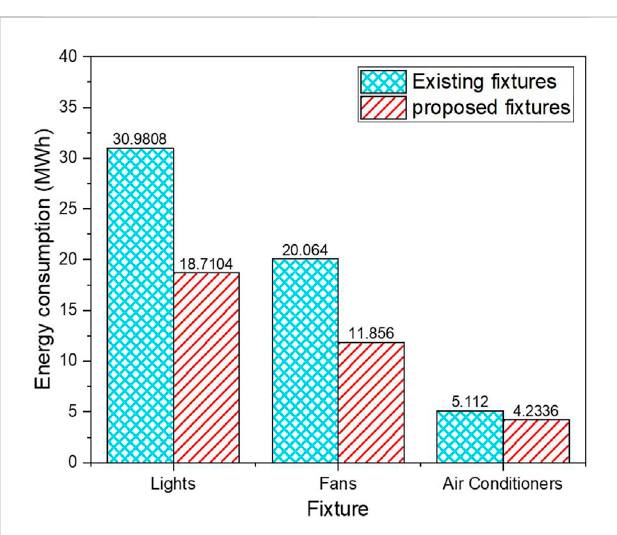
FIGURE 4 Difference in energy consumption of existing and proposed electrical fi xtures of the selected